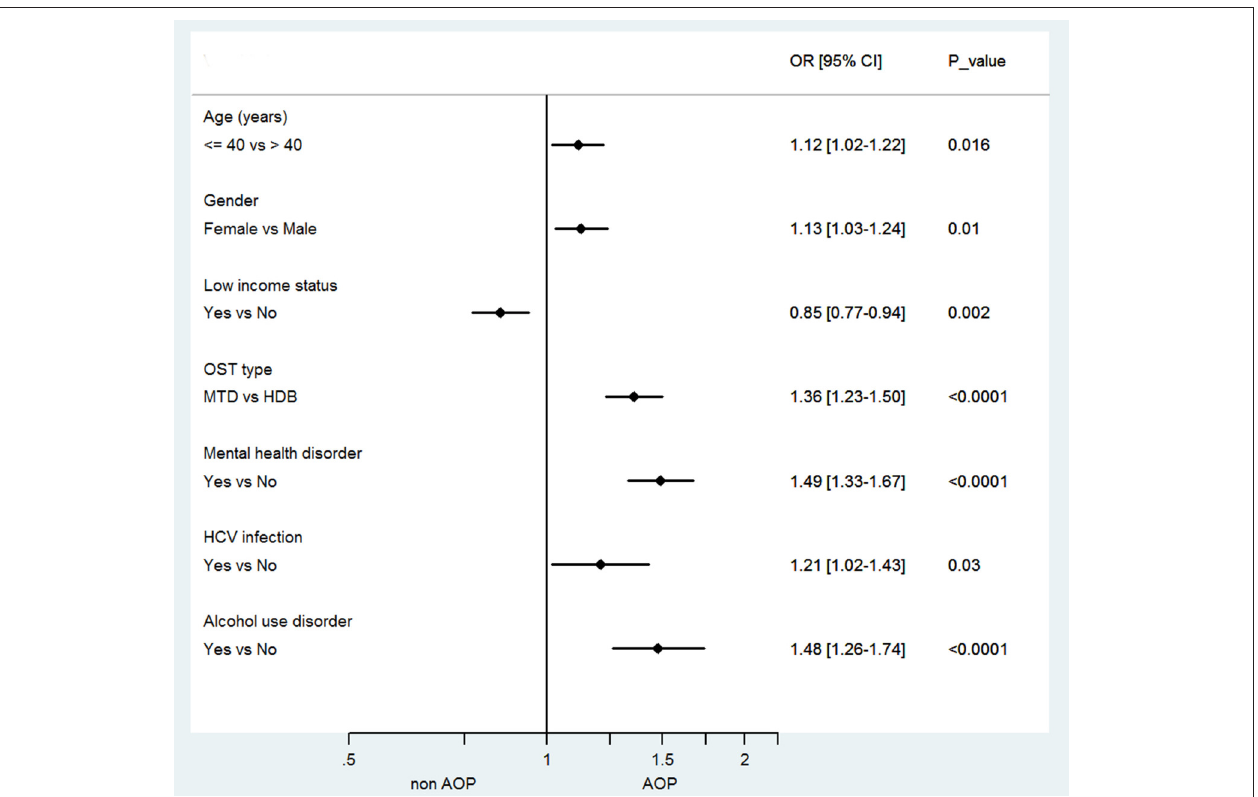
FIGURE 2 | Forest plot of factors associated with analgesic opioid prescription in chronic non-cancer pain opioid substitution treatment (CNCP OST) patients. OR, odds ratio; CI, confidence interval; AOP, analgesic opioid prescription; MTD, methadone; HDB, buprenorphine, HCV, hepatitis C virus; OST, Opioid Substitution